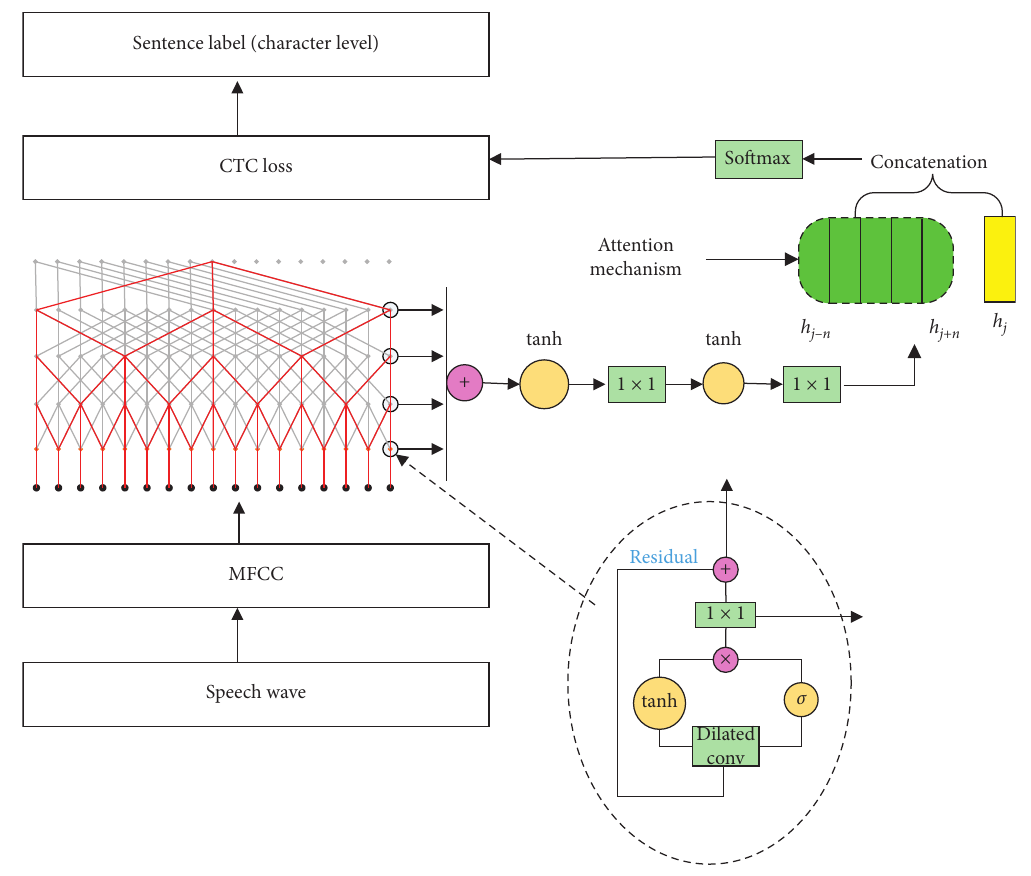
Figure 6: The architecture of WaveNet-attention-CTC. Table 1: The experimental data